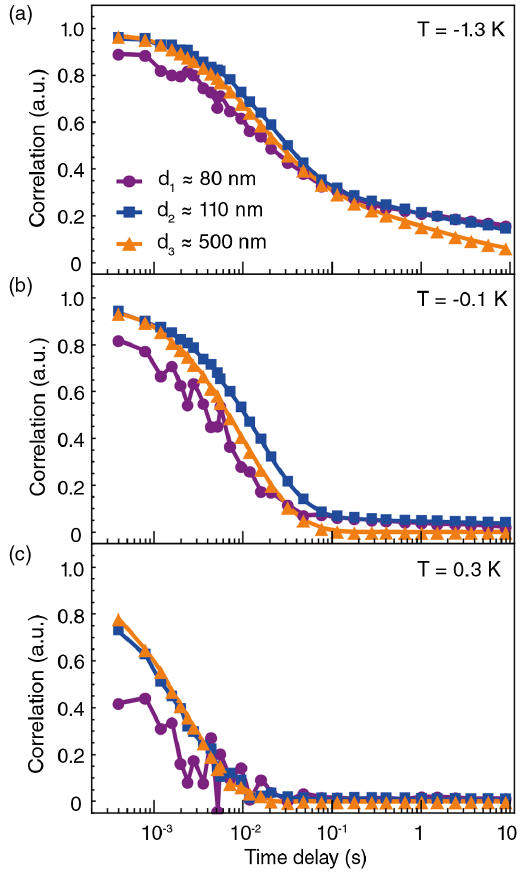
FIG. 7. Order-parameter dynamics in skyrmion phases of BPIII mixture measured by cDDM autocorrelation. (a) The dense skyrmionic phase at T ¼ − 1 . 3 K shows a slow relaxation “ tail, ” indicating the presence of static objects. (b) Just below the isotropic phase at T ¼ − 0 . 1 K, the slow tail in the autocorrelation functions is still observed, indicating two-mode dynamics. (c) A single relaxation mode is observed for all thicknesses in the isotropic phase at T ¼ 0 . 3